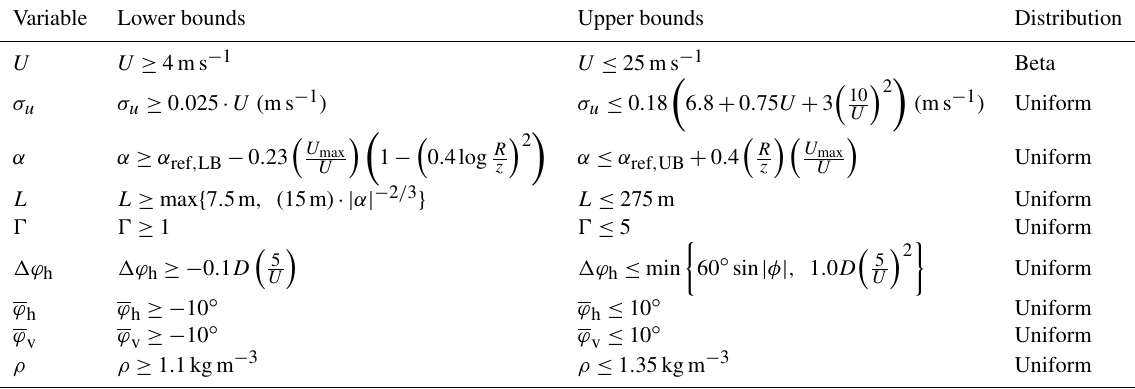
Table 1. Bounds of variation for the variables considered. All values are defined as statistics over 10min reference